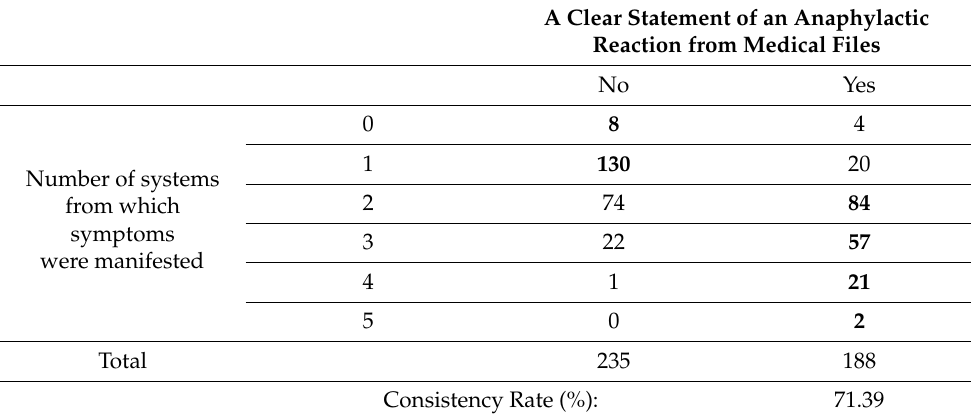
Table 2. Recording of “Anaphylaxis” diagnosis according to the number of systems involved.